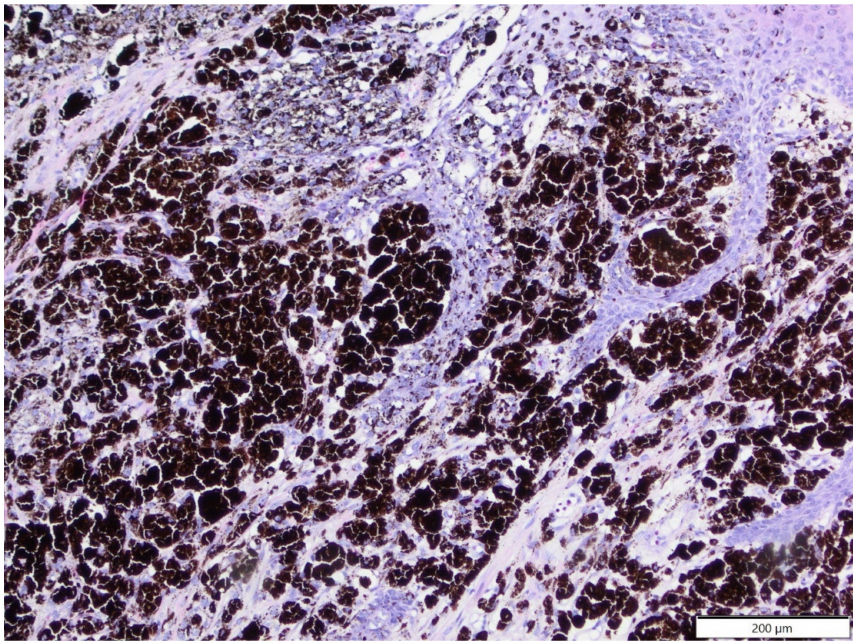
Figure 2. Compound melanocytoma, facial area, pet rabbit. Heavily melanised, well-differentiated tumour cells formed solid sheets and massively infiltrated the epidermis.